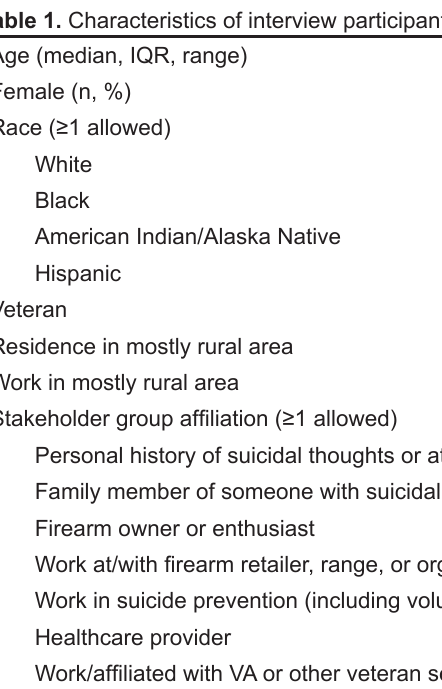
IQR, interquartile range; VA, Veterans